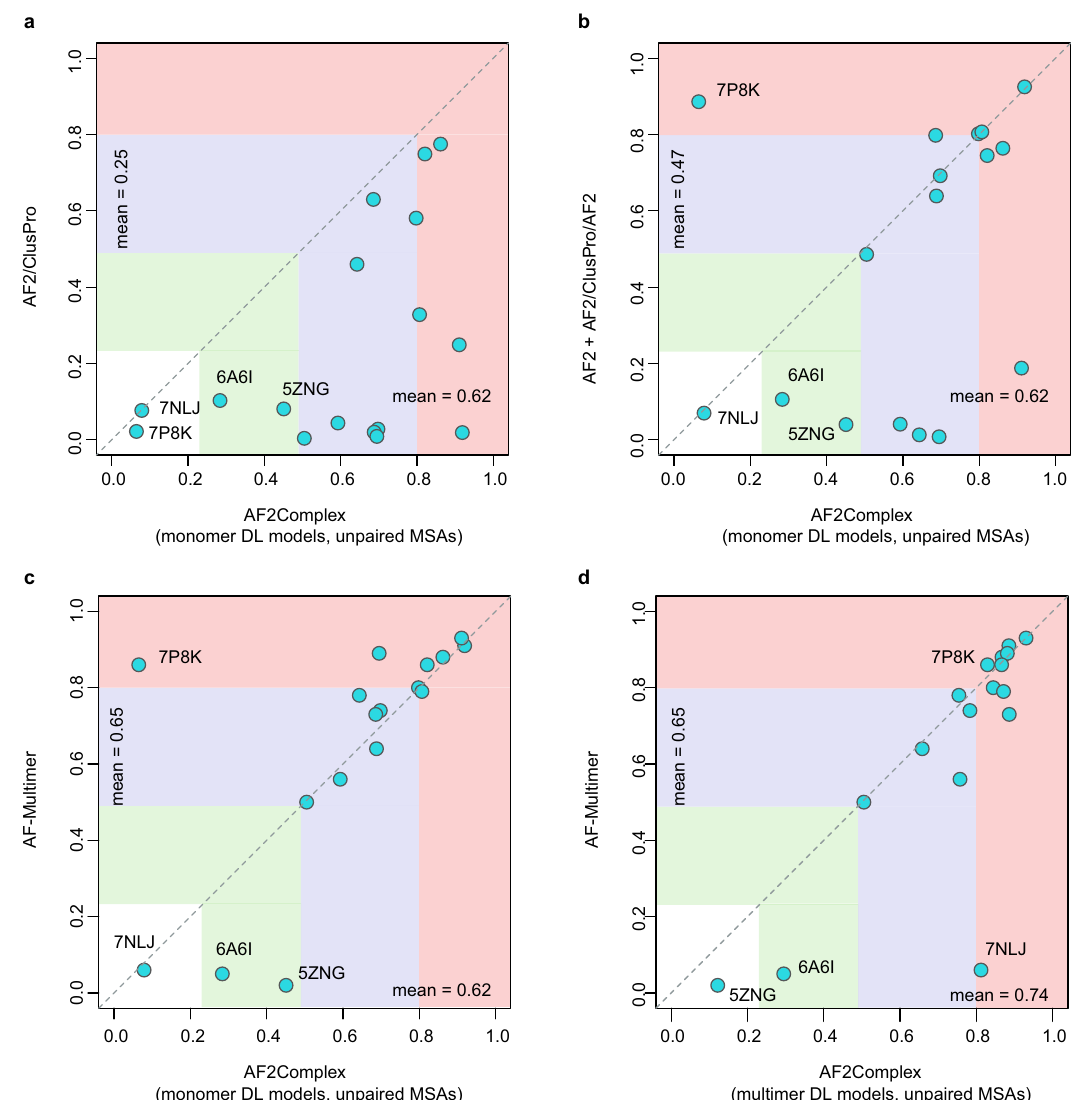
Fig. 3 Comparison of AF2Complex and three alternative approaches on the CP17 set. The coordinates of the circles correspond to the DockQ scores 42 of the top overall models from each approach versus AF2Complex. a AF2 models docked by ClusPro 22 . b Docking models re fi ned by AF2, plus additional complex models obtained by running AF2 on paired MSAs according to Ref. 22 . ( c , d ) AlphaFold-Multimer 35 . The AF2 deep learning models trained for the prediction of monomeric protein structures, denoted as “ monomer DL models ” , were employed by AF2Complex in (A – C), and the AF-Multimer deep learning models, denoted as “ multimer DL models ” , were applied with AF2Complex in ( d ). All MSA inputs to AF2Complex are unpaired as described in Methods. Vertical and horizontal blocks represent the regions of incorrect (white), acceptable (green), medium (blue), and high-quality (red) complex models according to the DockQ score. The four most challenging targets are marked by their four-letter PDB accession